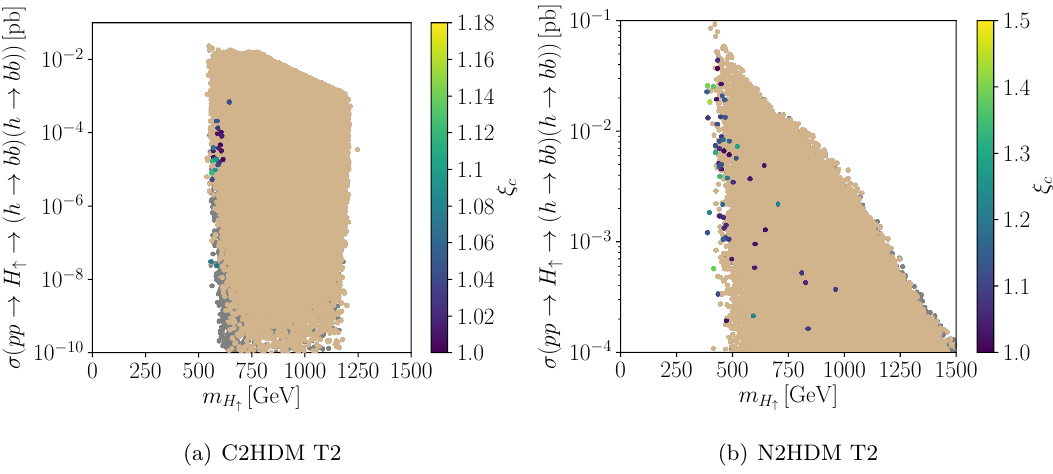
Figure 16 . T2: production rate of H " with subsequent decay into hh in the ( b (cid:22) b )( b (cid:22) b ) (cid:12)nal state versus m H for the C2HDM (left) and the N2HDM (right). The color code is the same as in " (cid:12)gure 3. The color bar indicates the strength of the phase transition for (cid:24) c search constraints are